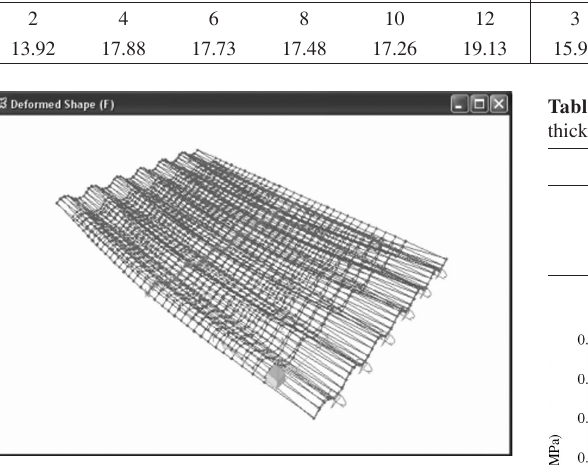
Figure 16. Global view of the deformed configuration of the sheets considering a vertical load of 2500 N/m under bending.